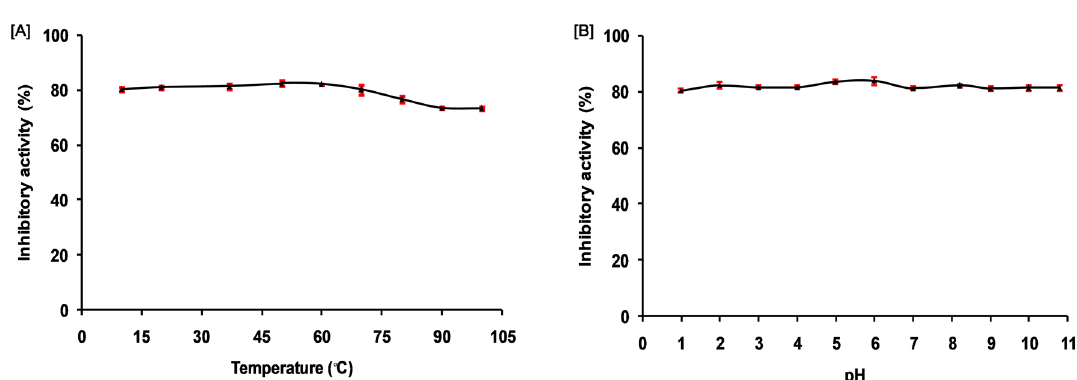
Figure 3. Stability of purified trypsin inhibitor ( A ) Temperature stability of purified SSTI incubation for 30 min at the indicated temperature, ( B ) pH stability of purified SSTI incubation at different pH for 30 min at 37